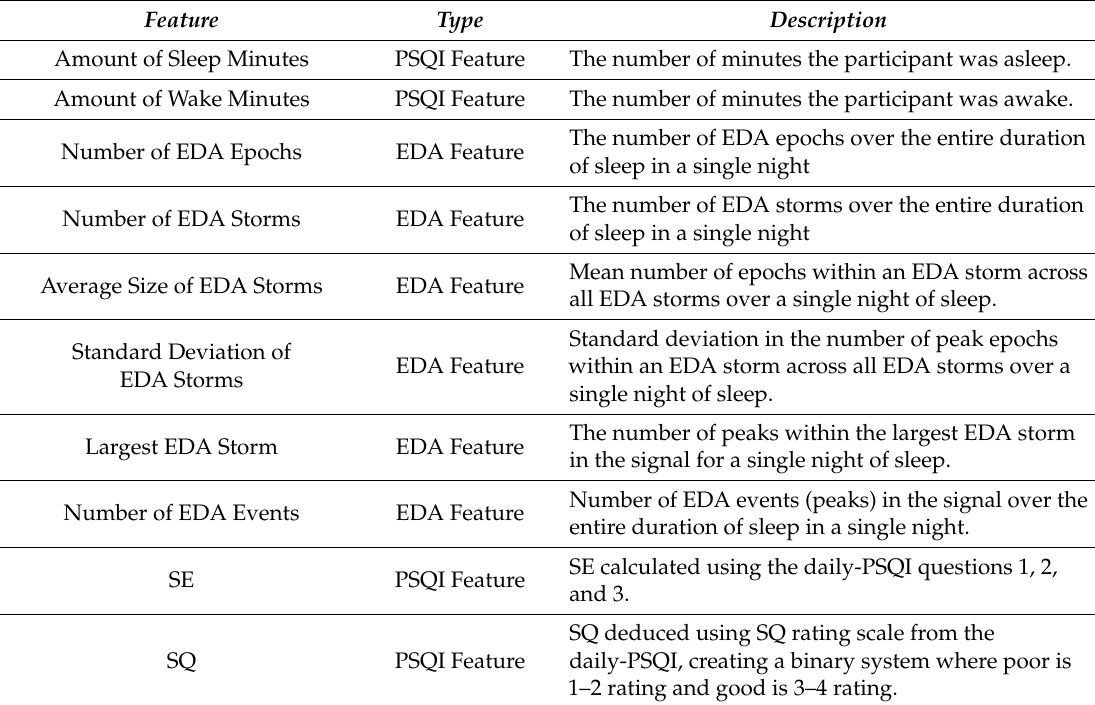
Table 1. EDA features extracted from the Empatica E4 and self-report features drawn from the